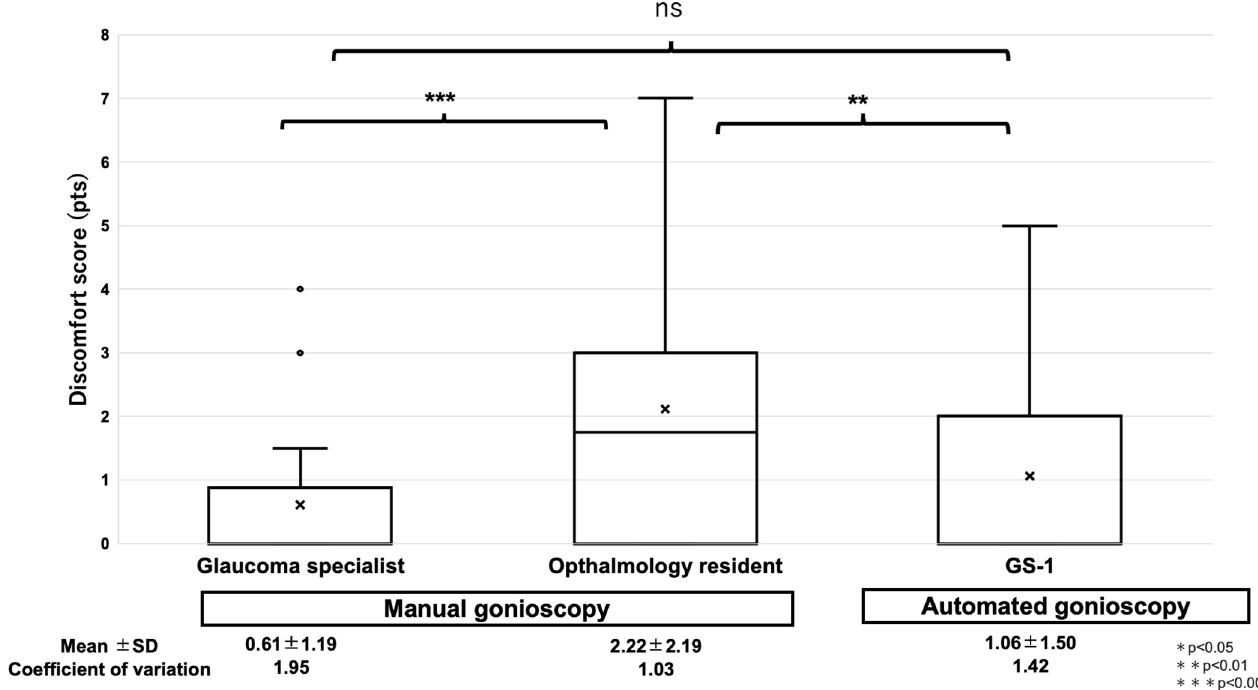
Fig 5. Analysis of the discomfort scores in the examinations by the glaucoma specialist, ophthalmology resident, and automated gonioscopy. * , ** , and *** represent p < 0.05, < 0.01, and < 0.001, respectively. ns represents statistically not significant.